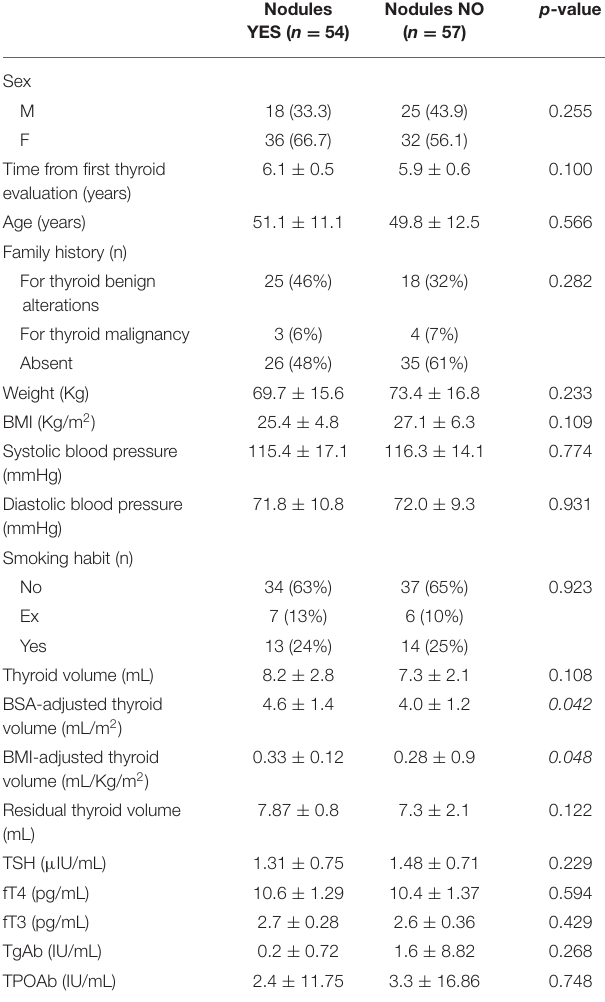
TABLE 3 | Comparison between subjects with and without thyroid